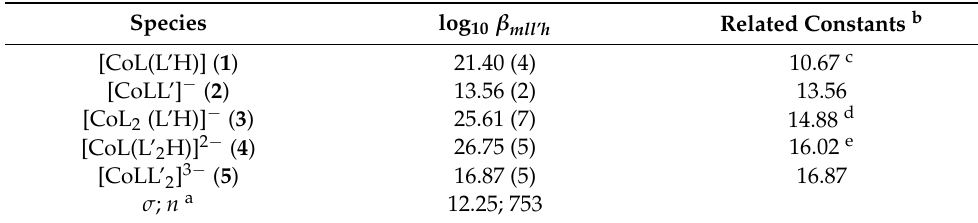
Table 1. Decimal logarithms of overall formation constants β mll’h = [M m L l L’ l’ H h ]/[M] m [L] l [L’] l’ [H] h at 25.0 ± 0.1 ◦ C, I = 0.1. The standard deviations given in parentheses after overall stability constants refer to random errors